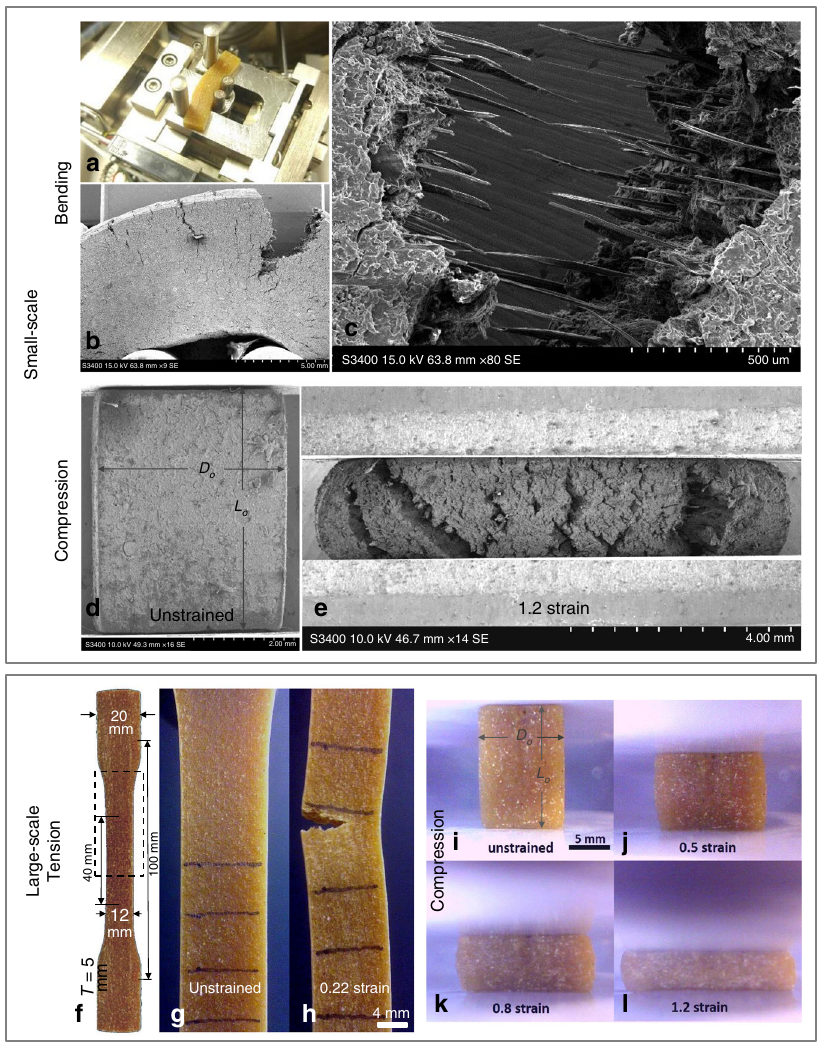
Fig. 1 Illustration of food mechanical characterisation. Small scale tests reveals damage/fracture mechanisms, whereas large scale tests provide stress- strain data as necessary key input parameters for the material constitutive law. a shows in-situ four point bending test under Scanning Electron Microscopy (SEM) (vacuum chamber is open for illustration – Hitachi S-3400N SEM equipment with load cell capacity of 200 N is used) with parameters: specimen length 30 mm, width 7 mm, thickness 4 mm, span length 7 mm, striker radius 4 mm, support radii 5 mm, striker speed 2.5 mm min − 1 , b crack propagation – tensile failure at striker displacement 3.8 mm, c crack faces detail highlight fi bre-bridging toughening mechanism. d shows in-situ compression SEM test at zero strain (specimen height × square edge = 5 × 4 mm), e specimen axial cracking and barrelling effects; due to signi fi cant barrelling the respective stress-strain data are not valid. f depicts tensile specimen (effective length × width × thickness = 100 × 12 × 5 mm — dashed box denotes optical window used to track strain), g optical frame of specimen at zero strain, d optical frame at tensile failure at 0.22 strain. i – l show optical frames of lubricated compression on cuboid specimens (height × square edge = 13 × 8 mm). For large scale tests (panels ( f – l )) an Instron 5543 universal testing machine with load cell capacity of 1 kN is